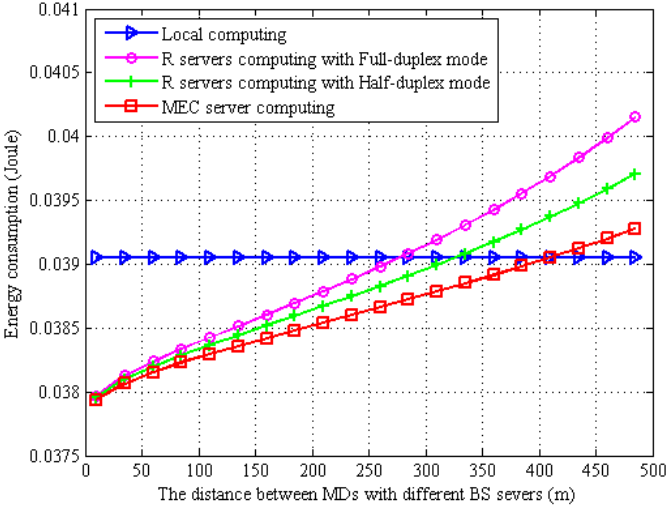
Figure 3. Energy consumption vs. different distance between MDs with BS